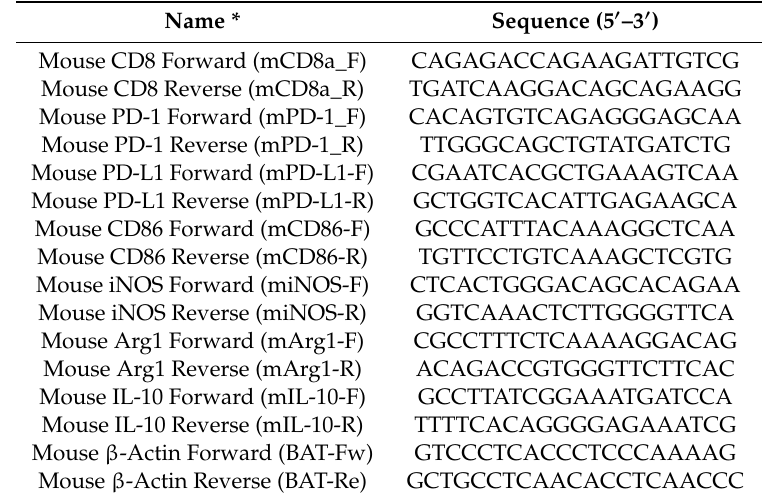
Table 1. Primers used in this